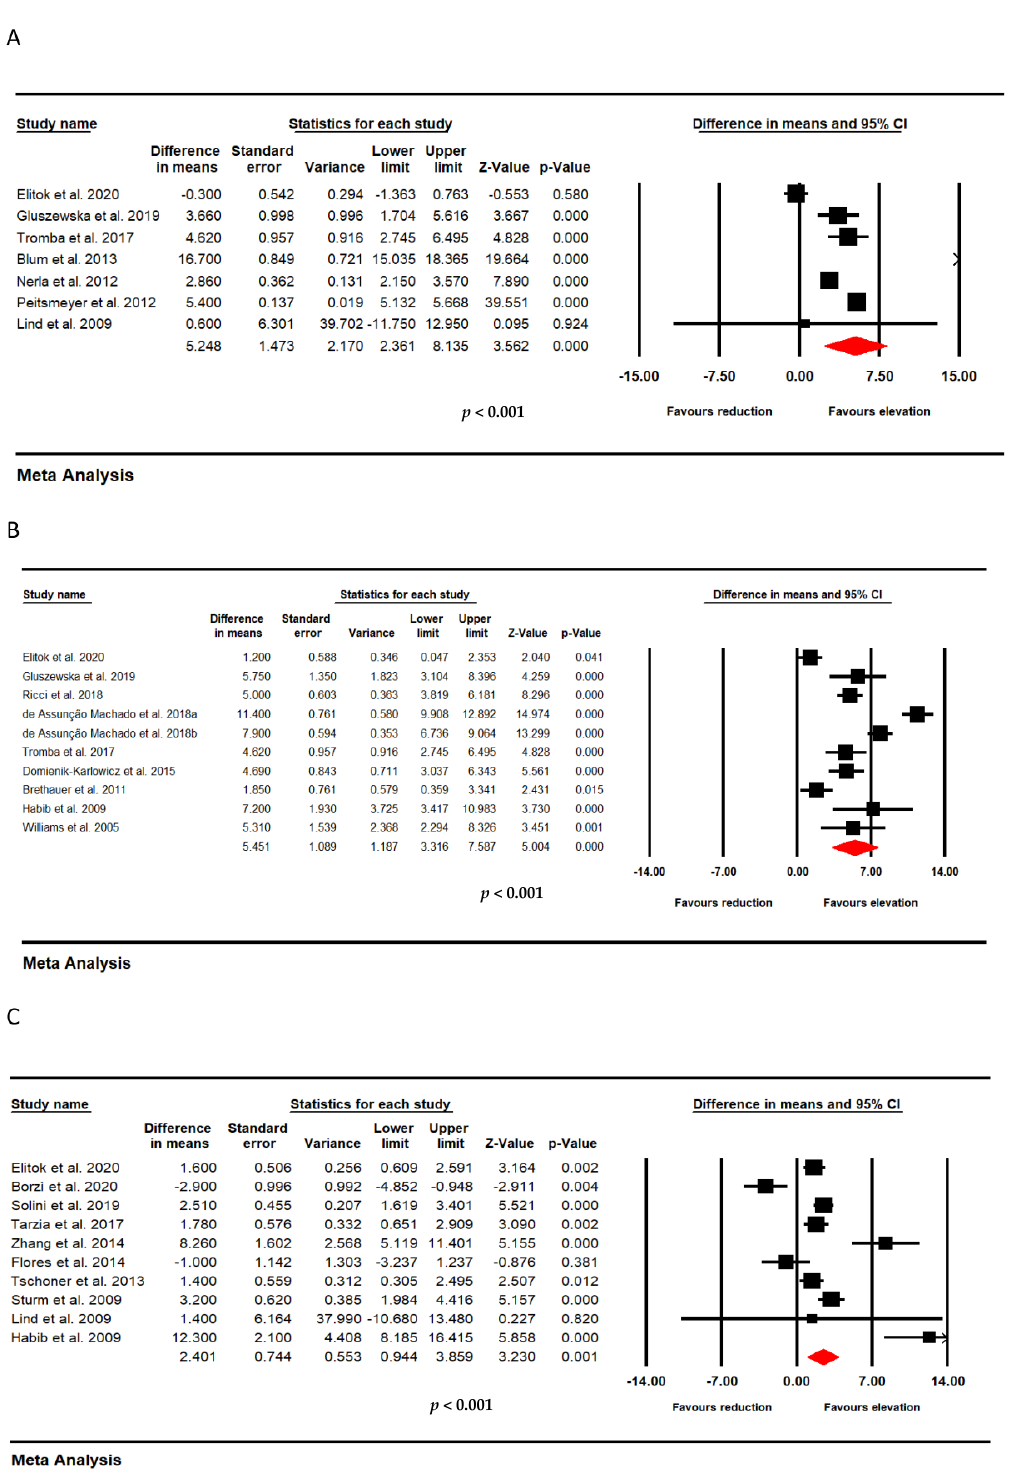
Figure 4. Effect of bariatric surgery on FMD at different follow up time point. ( A ): <6 months (356 subjects); ( B ) : ≥6 months < 12 months (414 subjects); and ( C ) : ≥12 months (414 subjects).